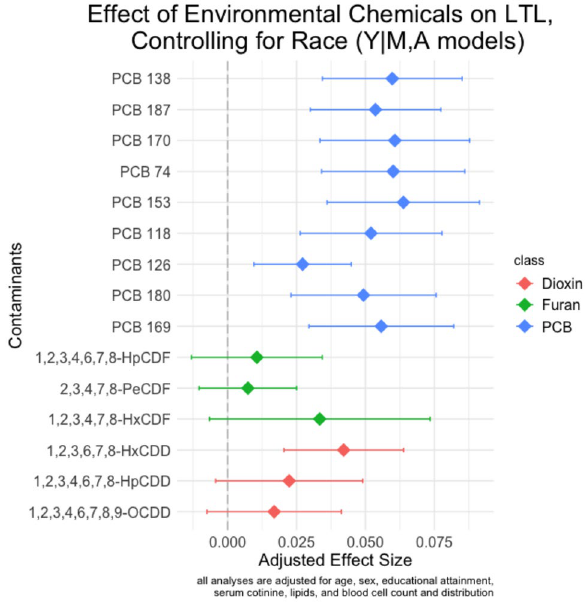
Figure 3. Results of the effect of environmental chemicals on leukocyte telomere length, controlling for self- reported race. Point estimates and 95% confidence intervals are